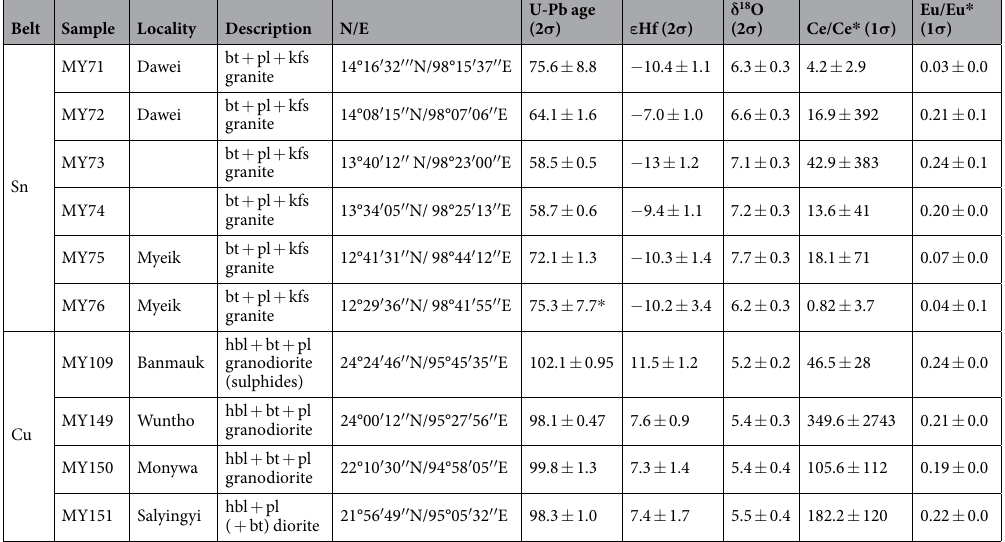
Figure 4 plots median zircon Ce/Ce * versus Eu/Eu * for the Myanmar suites. Copper arc zircons define a relatively restricted field with elevated Ce/Ce * and higher Eu/Eu * (more oxidizing, limited range of Eu/Eu * ). Tin belt zircons have lower Ce/Ce * and a wider range in Eu/Eu * , and samples with high whole-rock Sn contents notably have significantly lower Eu/Eu – i.e. a greater Eu anomaly -